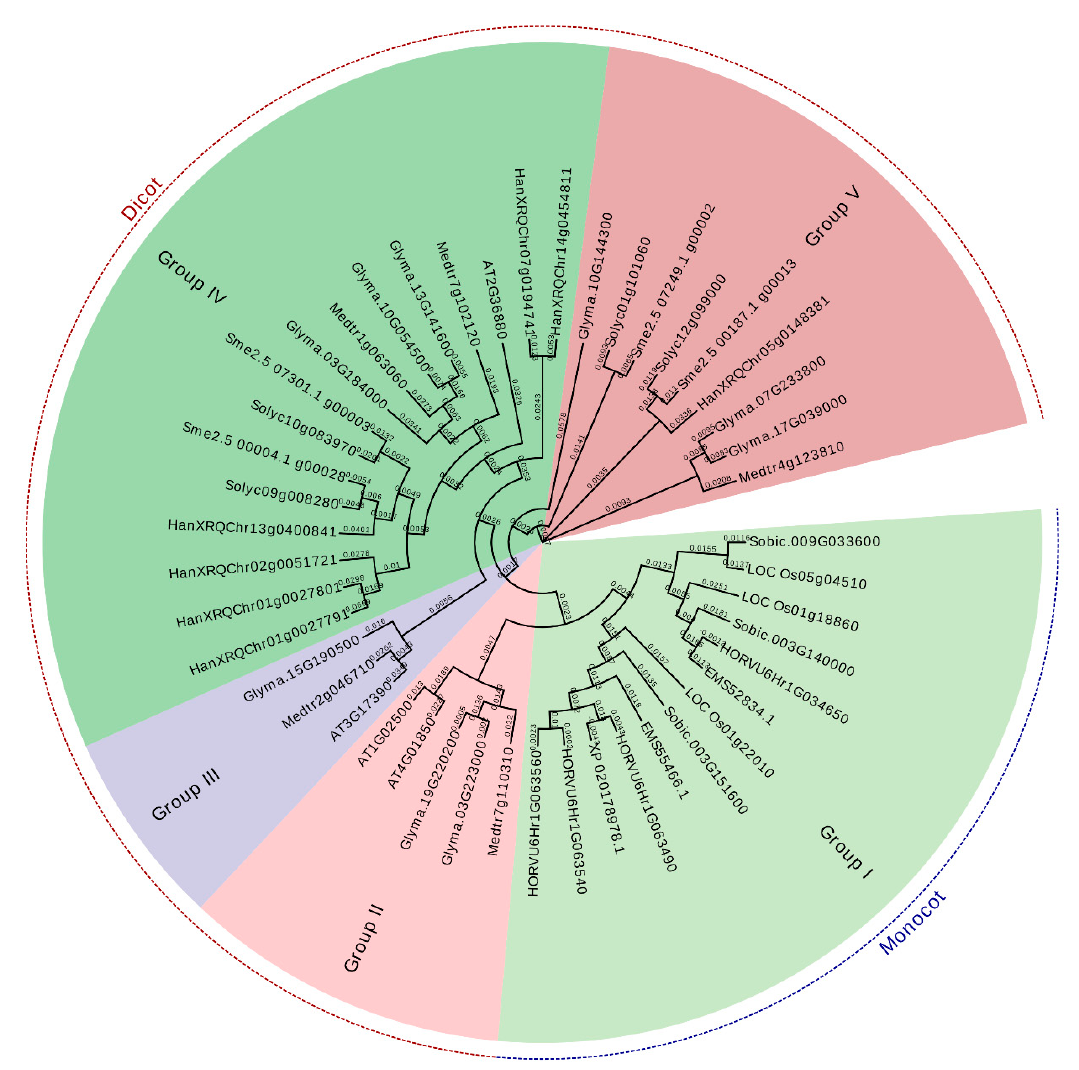
Figure 2. Phylogenic tree of SAMS gene-based amino acid sequences using the neighbor-joining method of Clustal Omega.